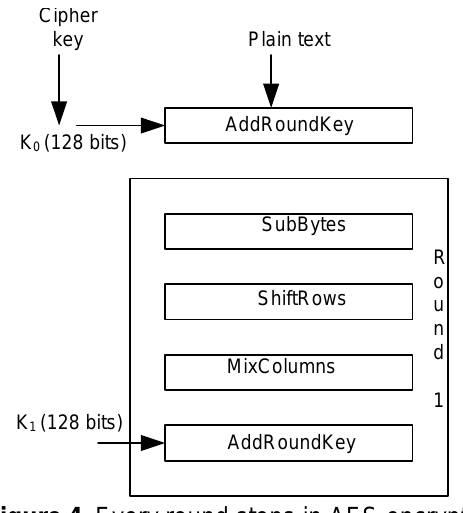
Figure 4 . Every round steps in AES